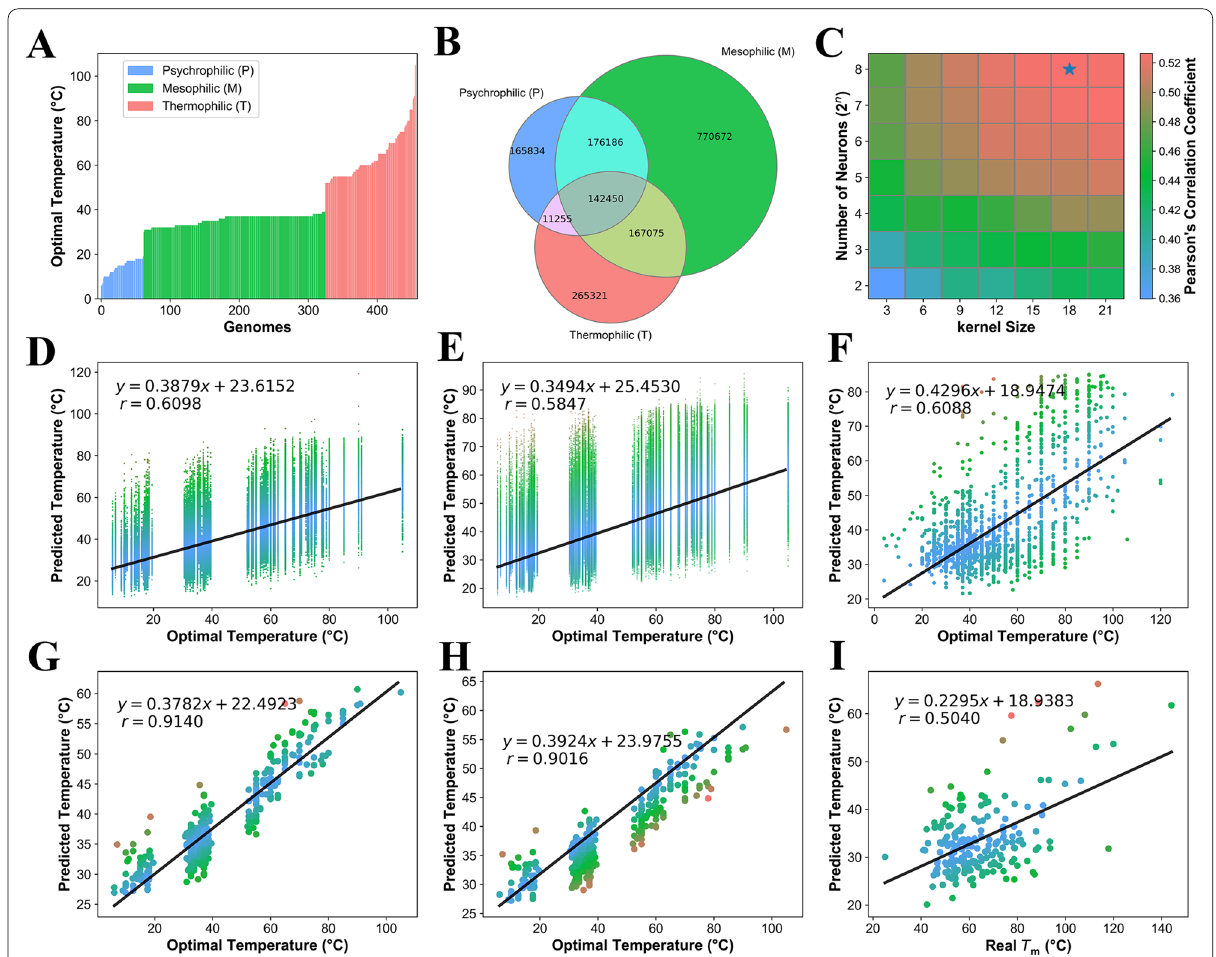
Fig. 1 Construction of a deep learning model to screen for potential thermophilic proteins. A Dataset collected in this study. The x-axis represents species sorted by optimal temperature and y-axis indicates optimal temperature. B Venn diagrams of the psychrophilic (blue), mesophilic (green), and thermophilic (pink) proteins. C Optimization of the parameters of kernel size and number of neurons in the deep learning model. Star indicates the highest value of correlation coefficient. D Correlation between the predicted and observed optimal temperatures in the validation dataset. E Correlation between the predicted and observed optimal temperatures in the test dataset. F Correlation analysis of predicted optimal temperatures for protein with known optimal temperature in the Uniprot database. G Correlation between the predicted and observed optimal temperatures in the cross-validation system. H Correlation between the predicted and observed optimal temperatures for a protein that is not included in the training dataset. I Correlation analysis of predicted optimal temperatures for protein activity and experimentally determined T m . D – I The blue dot indicates that the data are close to the fitted line, the red dot indicates that the data are far away from the fitted line, and the green dot